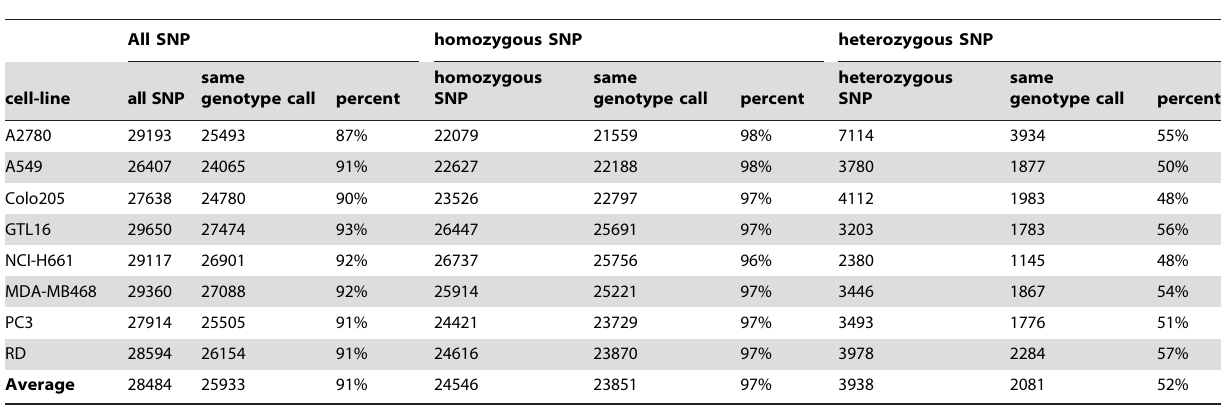
Table 2. Comparison of genotype calls by SNP 6 chip and exome sequencing.